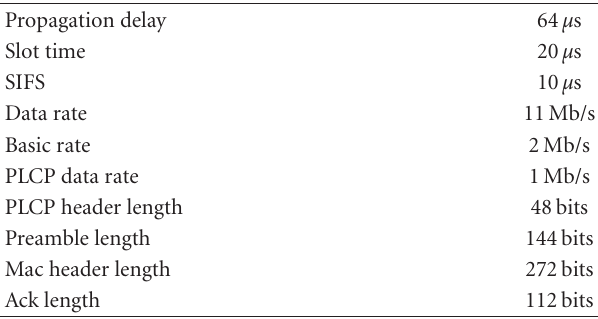
Figure 7: Transmission during TXOPLimit. Table 2: 802.11 parameter settings.